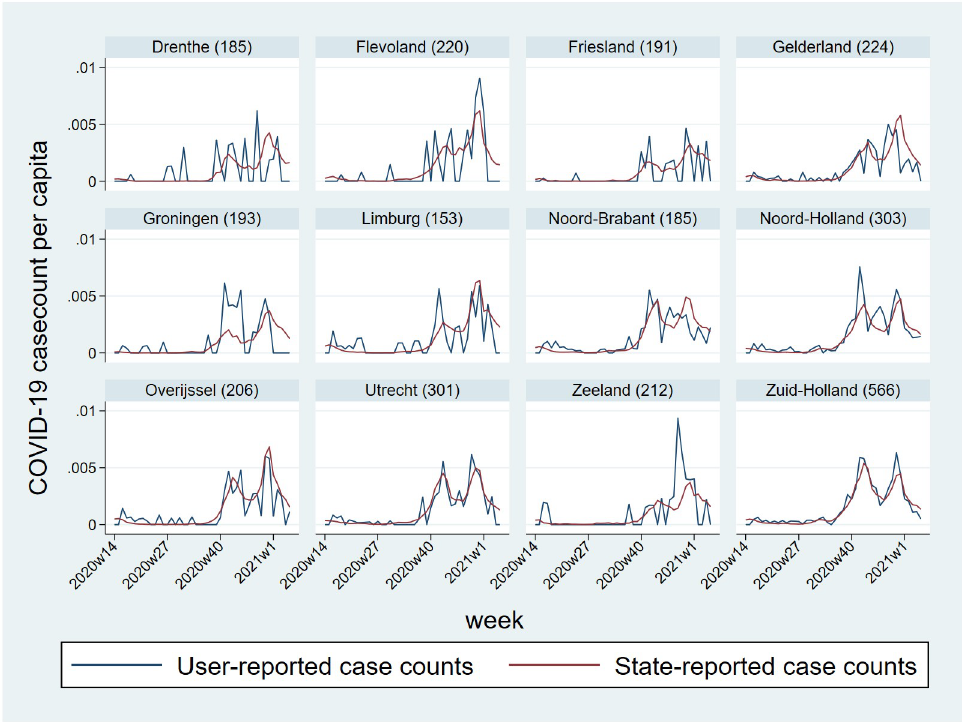
Fig 7. Weekly proportion of SARS-CoV-2 positive users reported in the COVID Radar app and case count per capita as reported by the RIVM for each province. (the number written beside the name of each province represents the mean number of weekly unique users per 100.000 inhabitants in that province during the study